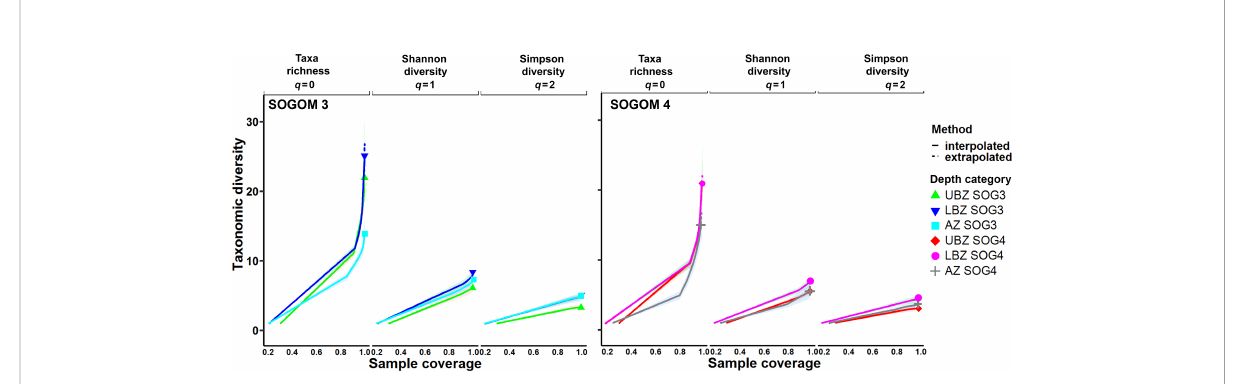
FIGURE 11 SOGOM 3, and SOGOM 4 coverage-based R/E (rarefaction and extrapolation) sampling curves for three Hill numbers (q = 0, 1, and 2). Upper bathyal zone (UBZ); lower bathyal zone (LBZ) and abyssal zone (AZ).